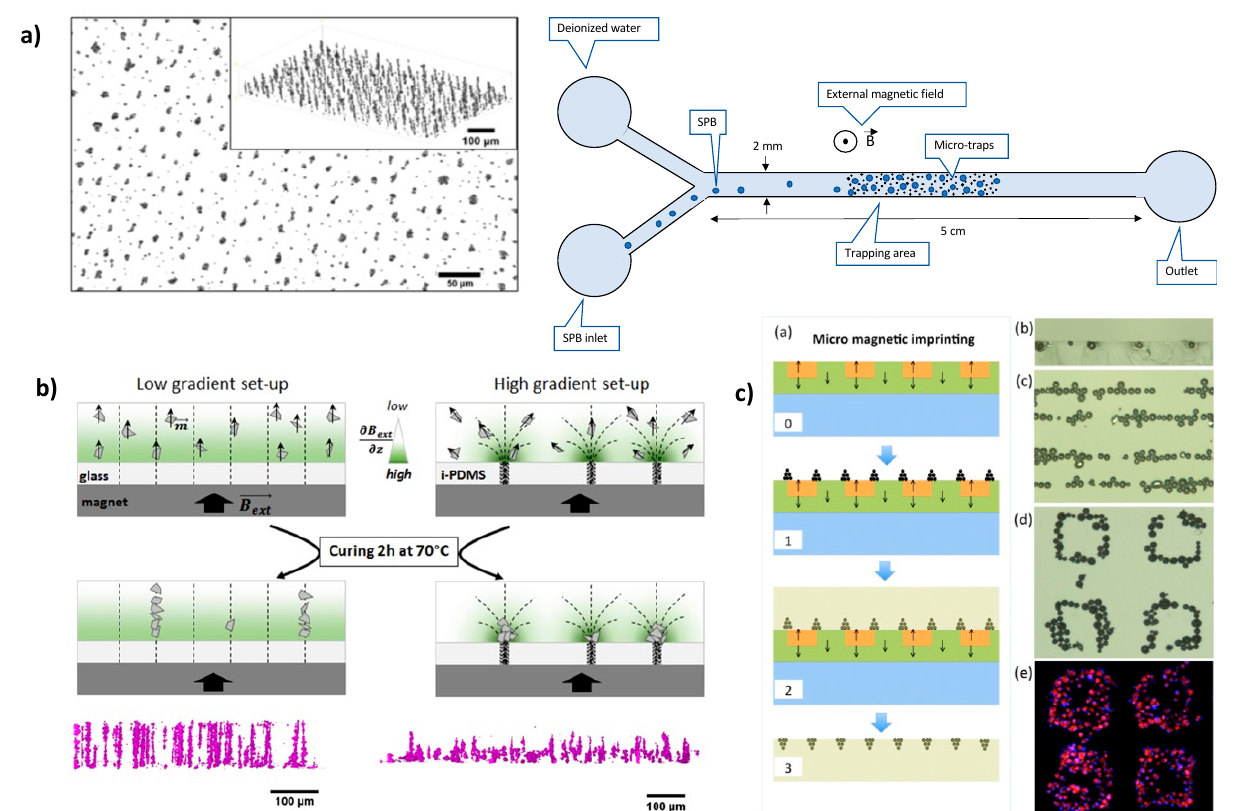
Figure 3. Examples of microstructure engineering by replication of a magnetic template. ( a ) X-ray tomography images of microstructured I-PDMS presenting arrays of columnar iron particle agglomerates. Adapted with permission from [70]. Copyright (2020) American Chemical Society. ( b ) Schematic views and X-ray tomography images of microstructured NdFeB@PDMS composite membranes prepared with two magnetic field patterns, leading to arrays of either columnar or conic agglomerates of NdFeB particles. Adapted with permission from [71]. ( c ) Fabrication scheme of NdFeB-PDMS membrane by micro-magnetic imprinting. Reprinted from [21] with permission of AIP